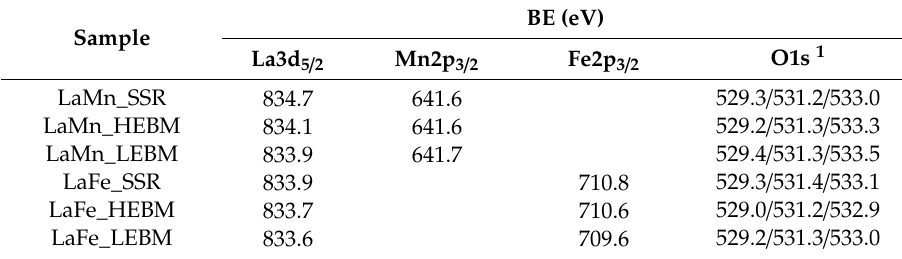
Table A1. Binding energies of LaMnO 3.15 and LaFeO 3 samples’ XPS components.